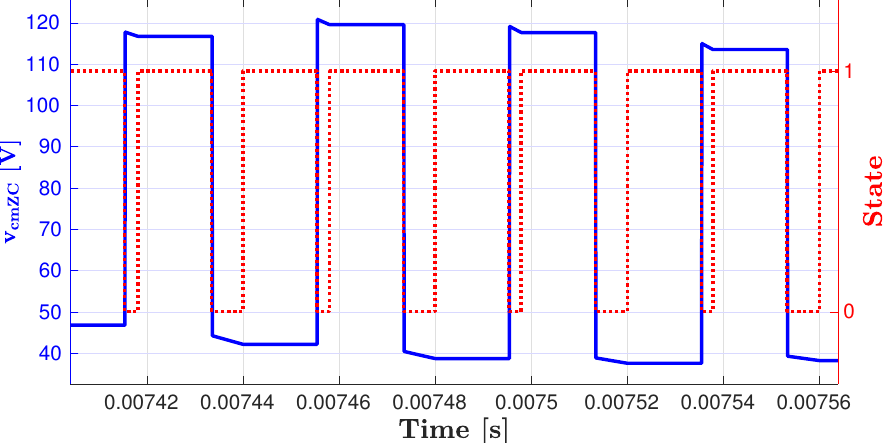
Figure 11. v cmZC evolution in case of Zero Vector (State 0) and any Active Vectors (State 1).